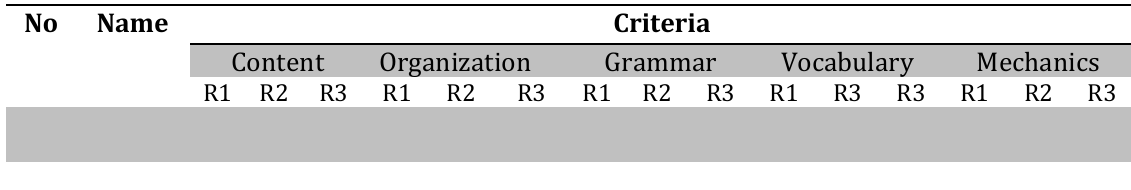
Table 1. The Students’ Problem in Writing Personal